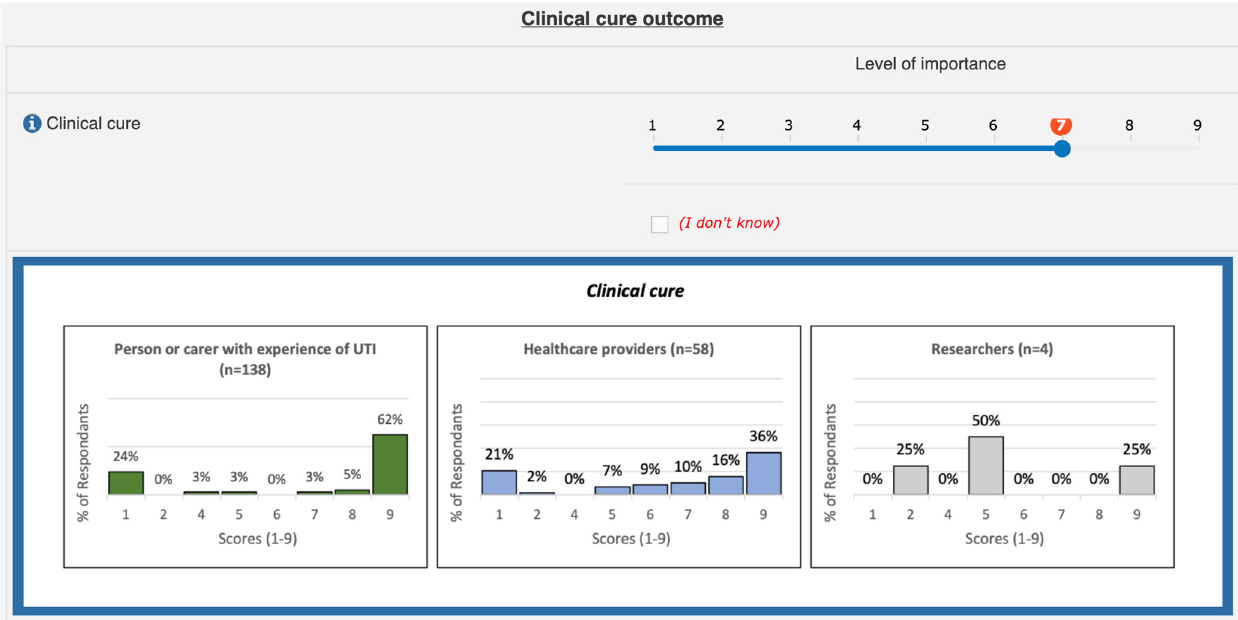
Figure 1. Presentation of round 1 Delphi survey results.